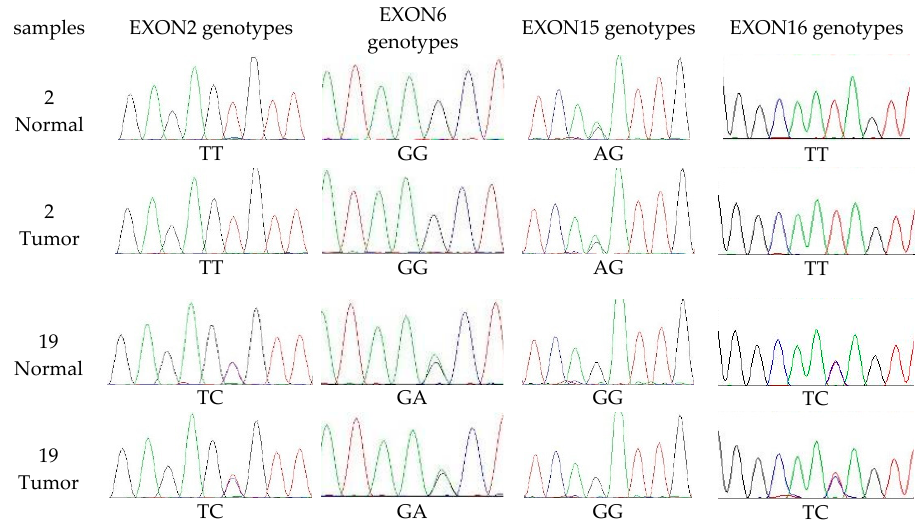
Figure 5. Genotypes of cMSH2 exons in tumor and normal canine mammary samples.